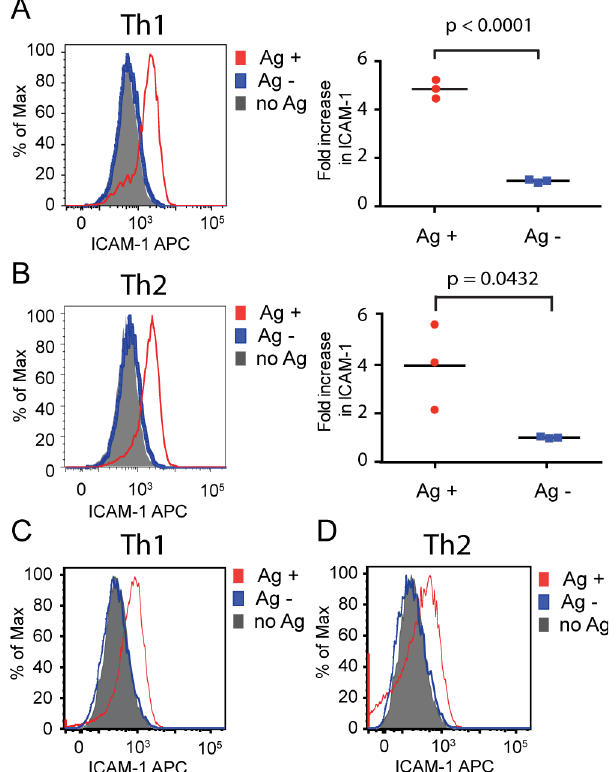
Fig 3. Th2 cells expressingpreformed CD40L help only antigen-presenting B cells. Upregulation of ICAM-1 was measuredon mixed antigen-pulsed (Ag+, red) and bystander(Ag-, blue) B cells following overnight incubationin a 12 well plate with Th1 ( A ) and Th2 ( B ) cells in the presenceof CsA to block de novo CD40Lsynthesis. Representative histograms are shown in the left panels. ICAM-1 on B cells cultured with T cells but without antigenin the well (no Ag) is shown as solid gray histograms. The panelson the right show mean fold increasein ICAM-1 fluorescent intensity on antigen-pulsed and bystandercells comparedto the control without antigen(set to 1) in three experiments. ( C, D ) The same experimentwas performed with T cells, antigen-pulsed B cells, and bystanderB cells spun together and cultured in a 96 well round-bottom plate to enhancecell contact. Th1 histograms are representative of three independentexperiments. Th2 histograms are representative of two independentexperiments. ICAM-1 levels for the control lackingantigen are shown in solid